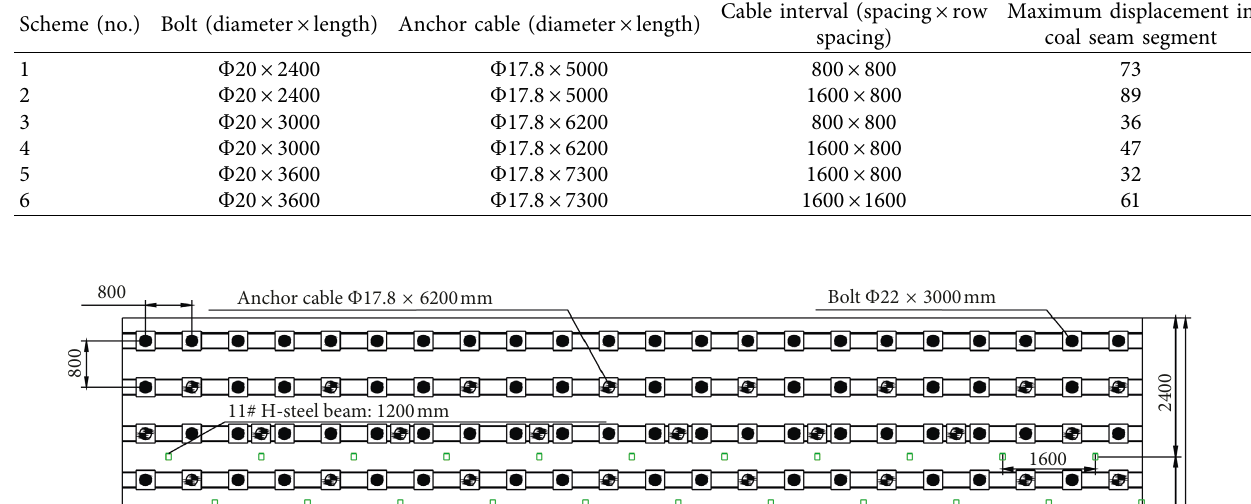
Table 4: Six different reinforcement schemes and their control effect (unit: mm).